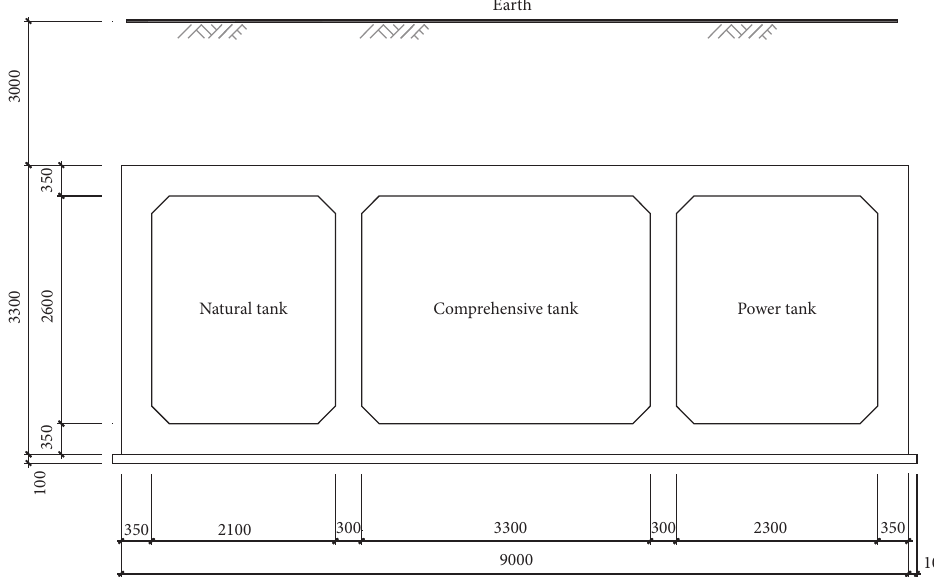
Figure 2: Schematic diagram of cross section of pipe gallery (unit: mm).